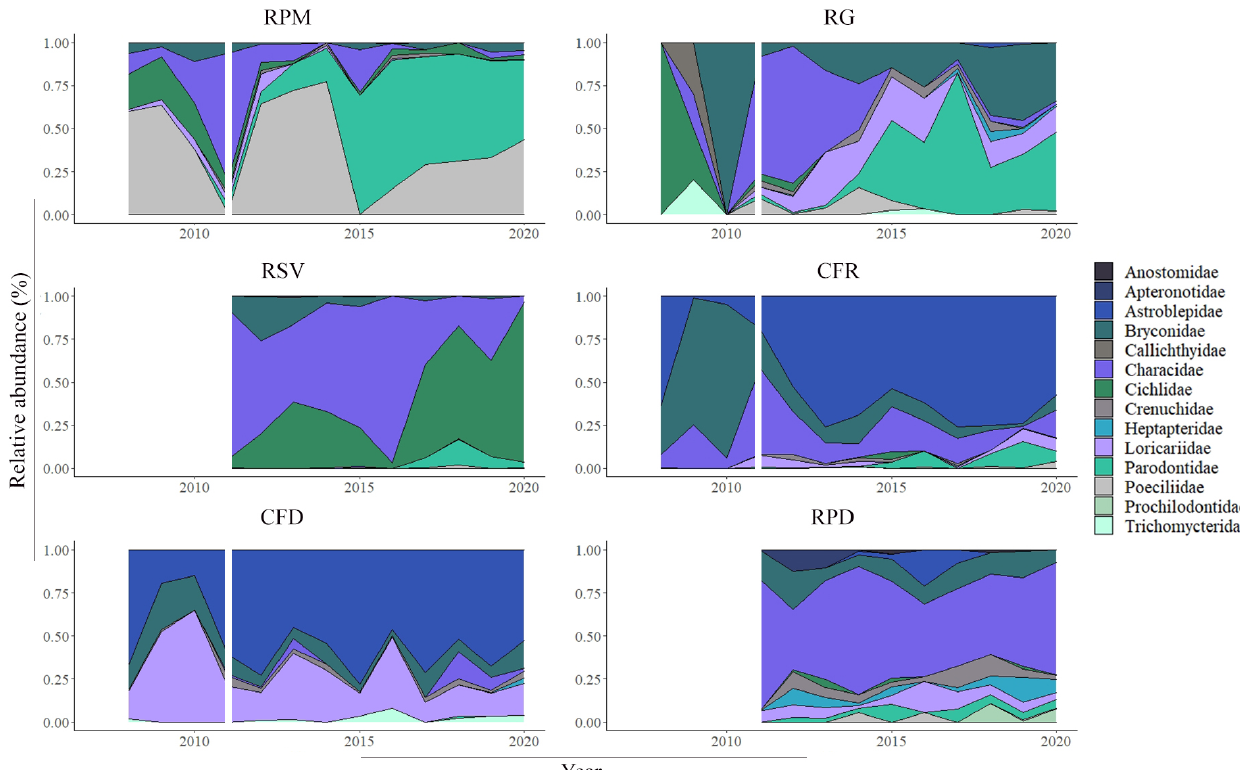
FIGURE 2 | Changes in relative abundance over time in each aquatic environment (RPM) Porce River isolated between the dams, (RG) Guadalupe River, (RSV) Reservoir, (CFR) Creeks flowing to the reservoir, (CFD) Creeks flowing to the Porce River below the dam, and (RPD) Porce River below the Porce III dam. White vertical line represents the year of filling and separates the years of pre-construction and post- filling of the